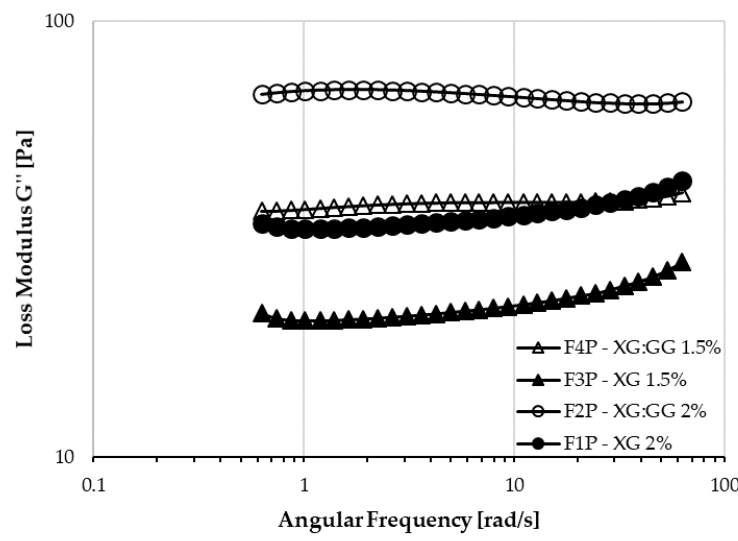
Figure 4. Plots of log ω versus log G ″ of XG and XG:GG mixtures.